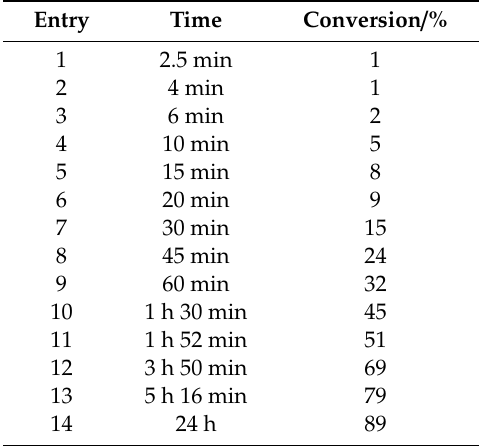
Table A1. Reduction of acetophenone ( 1 ) to 1-phenylethanol ( R )- 2 . Change from standard procedure: none. Entry